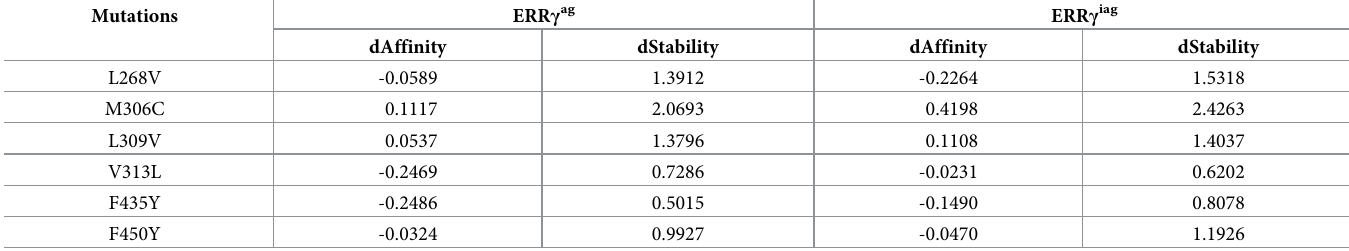
Table 3. Computation mutagenesis of hydrophobic residues involved in ligand binding. dAffinity and dStability represent the relative binding affinity and relative thermostability of the mutated to wild-type ERR γ , respectively.